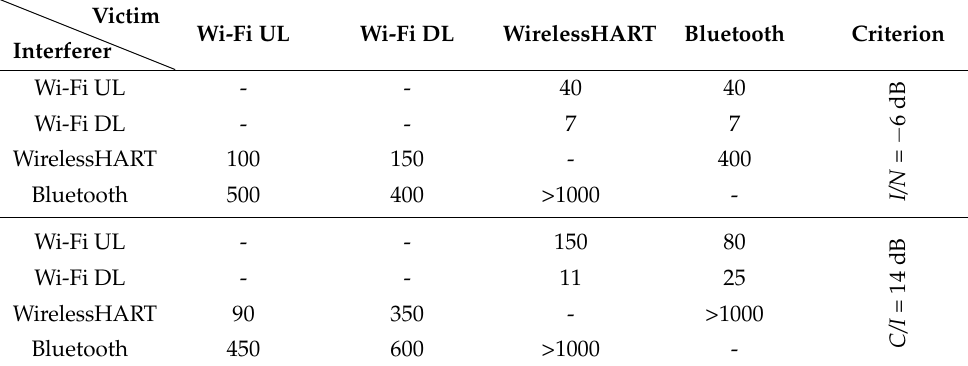
Table 2. The maximum number of interferers on the factory shop floor for a 1% probability of